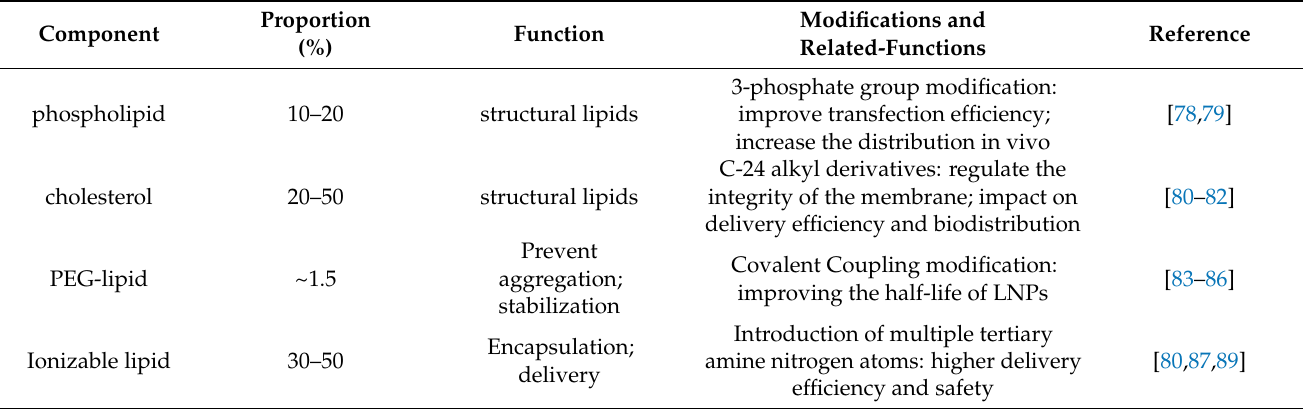
Table 3. Composition and function of LNP in mRNA vaccines